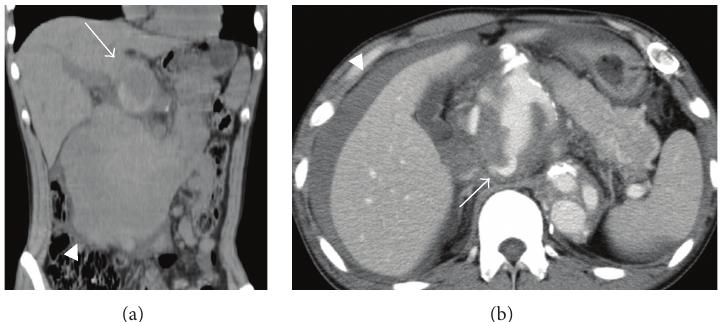
Figure1:(a)NonenhancedCTshowsananeurysm(arrow)ofthecommonhepaticartery,withahematoma(arrowhead)extendinginferiorly. (b) Contrast-enhanced CT two and a half hours later reveals extravasation (arrow) from the aneurysm and hematoma extending to the lateral aspect of the right lobe of the liver (arrowhead).